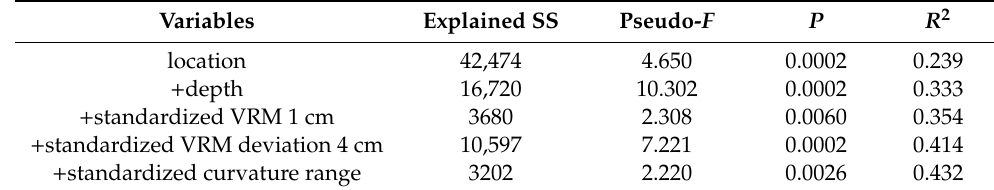
Table 1. Results of DISTLM conditional tests for the structure of fish assemblages as a whole on the basis of Bray-Curtis dissimilarity after square-root transformation of fish abundance. Explanatory variables used were geographical locations, depth, standardized mean VRM at 1-cm resolution, standardized mean VRM deviation at 4-cm resolution and standardized curvature range. None of the benthic cover variables further improved the model on the basis of AICc. The “ + ” in the variables column denotes an addition of the explanatory variable to the model.